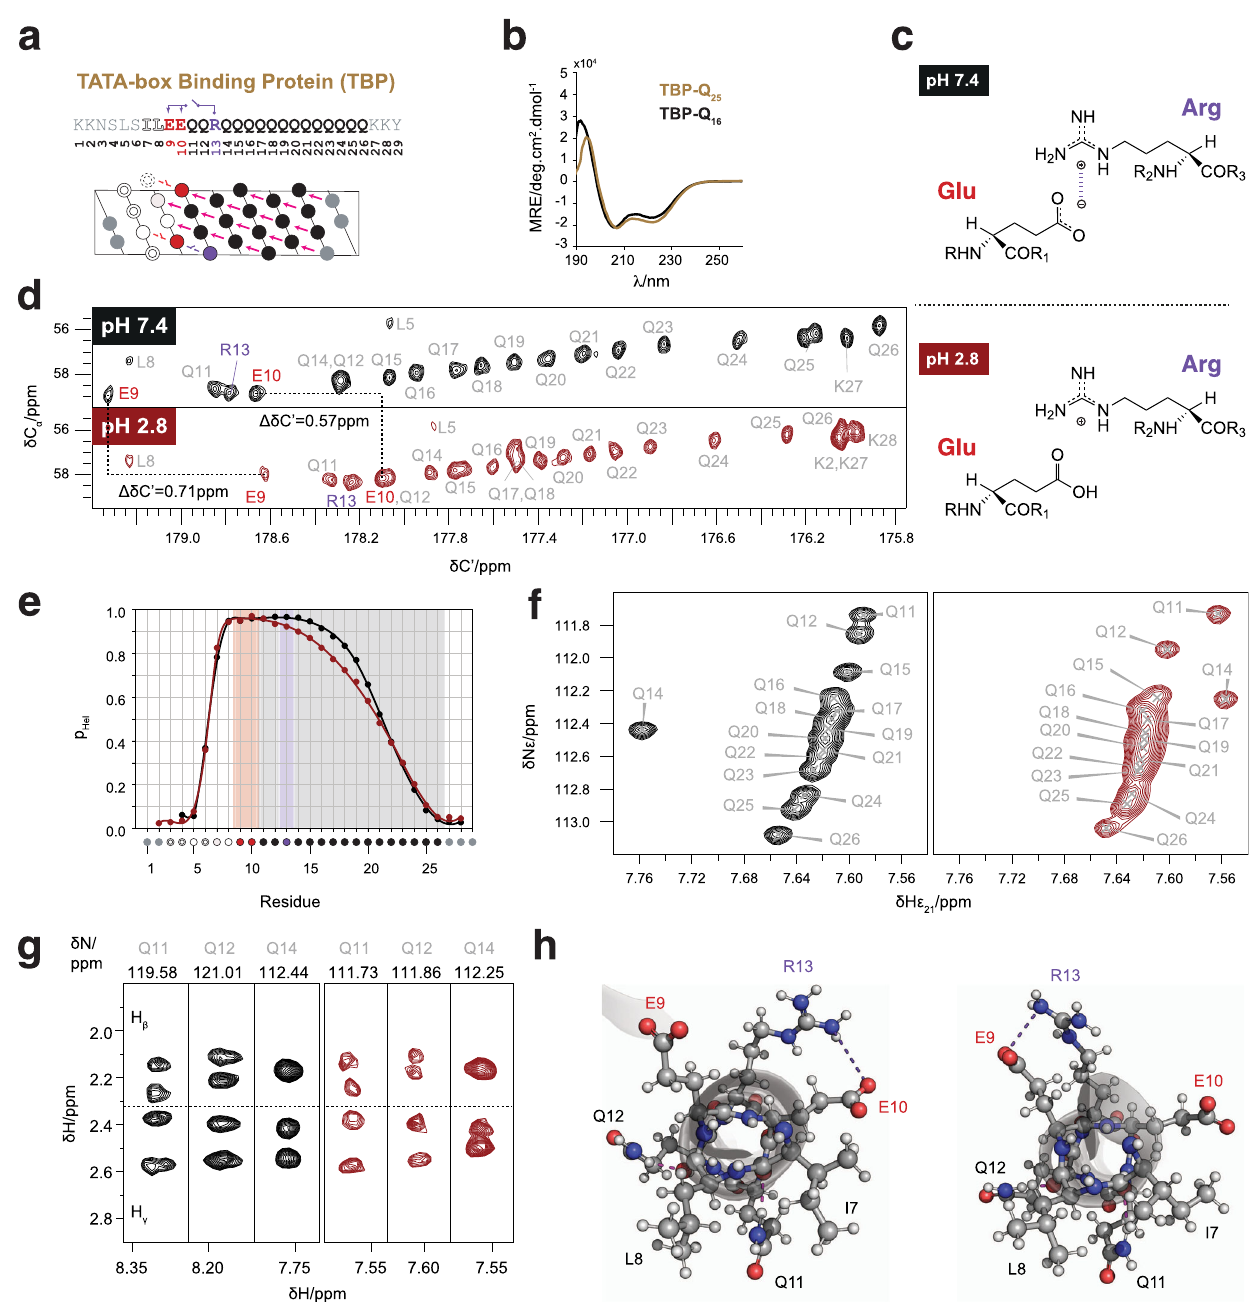
Fig.5|ThepolyQtractofTBPformsahelixstabilizedbyGlnsidechaintomain chainhydrogenbondsandanelectrostaticinteraction.a Sequence, numbering and helical projection of peptide TBP-Q 16 . The electrostatic interaction is color- coded in purple. b CD spectra of peptides TBP-Q 16 (black) and TBP-Q 25 (gold). c Scheme of the electrostatic interaction between Arg and Glu at physiological pH anditsabsenceatacidicpH. d 13 C-detectedCACOspectraoftheTBPpolyQtractat pH 7.4 (top,black) and 2.8 (bottom, dark red). e Residue-speci fi c helicity of TBP at pH7.4(black)and2.8(darkred).Shadescolor-codedasin a areshowntoguidethe eye. f Regionofthe 1 H- 15 NHSQCspectraofTBPatpH7.4(left,black)and2.8(right, dark red) showing the N ε 2 -H ε 21 correlations. g Strips from the 3D H(CC)(CO)NH